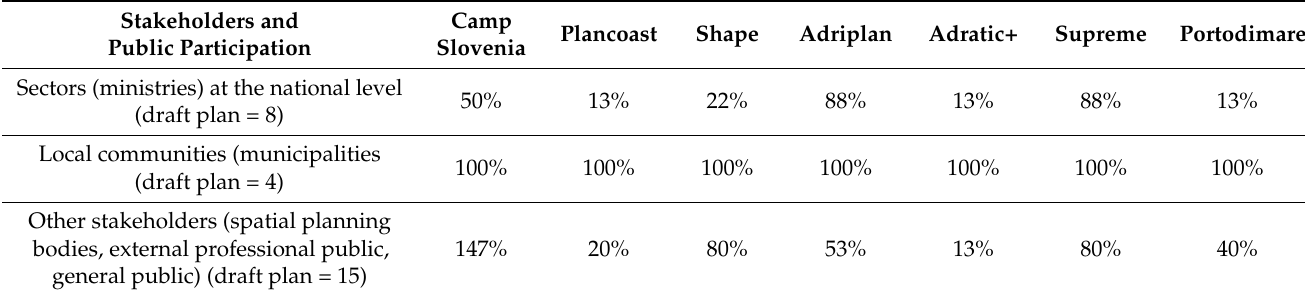
Table 7. Comparison of the draft plan and individual projects: participating stakeholders (sectors, local communities, and other stakeholders); the basis for the calculation are the invitees and participants in the draft plan (100%). Stakeholders